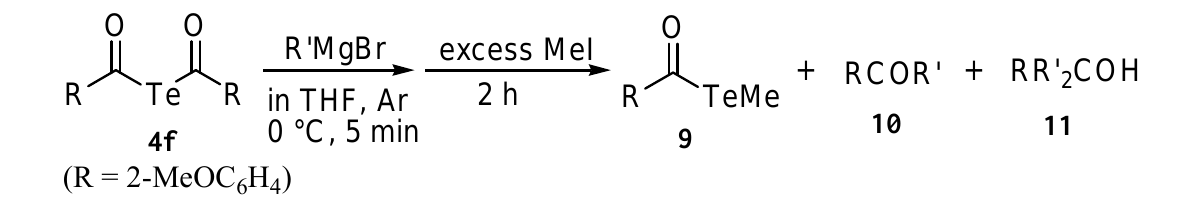
H CO) Te ( 4f ) with Grignard reagents. 6 4 2